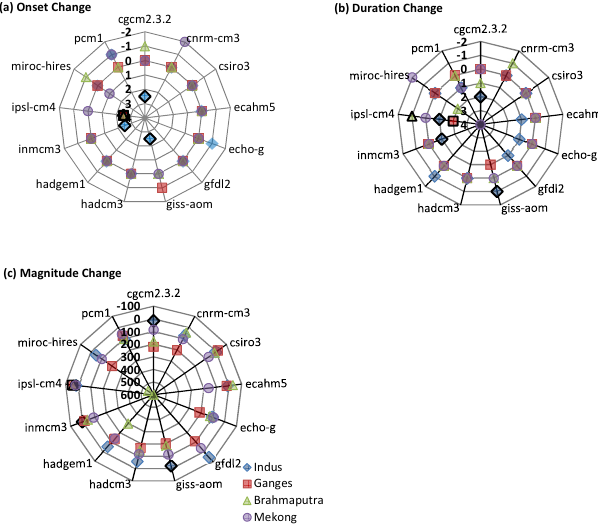
Fig. 7. Change for the 21st century climate (2061–2100) relative to 20th century climate (1961–2000), (a) in the timings of the mon- soon onset month, (b) in the monsoon duration, (c) in magnitude of the monsoonal precipitation in mm. Positive values indicate the delayed onset and prolonged monsoon duration in months and in- creased magnitude of monsoonal precipitation in mm, while the negative values indicate the opposite. Note that GCMs which do not simulate the monsoon precipitation regime at all for the particu- lar basin (markers with black border) are only shown for indicative